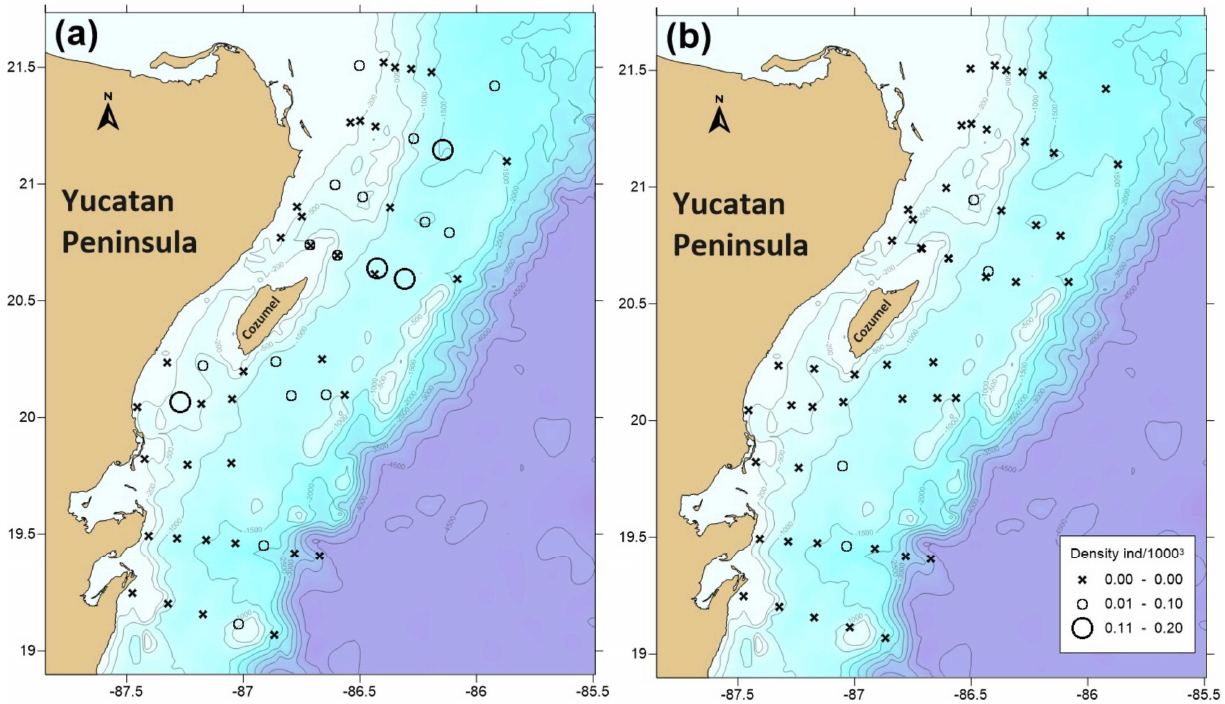
Figure 10. Density (number of larvae per 1000 m 3 of water) of ( a ) mid-stage phyllosomata and ( b ) late-stage phyllosomata of Parribacus antarcticus by sampling station during the autumn 2012 cruise. The scale is the same for both panels.